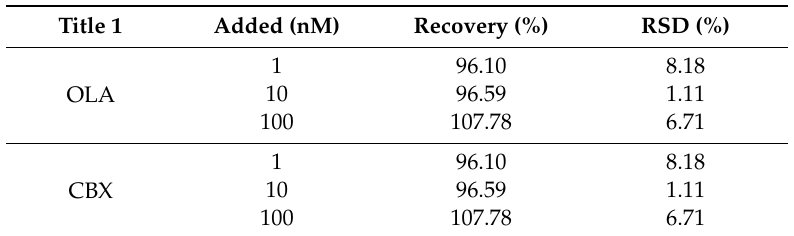
Table 2. Real samples analysis ( n =